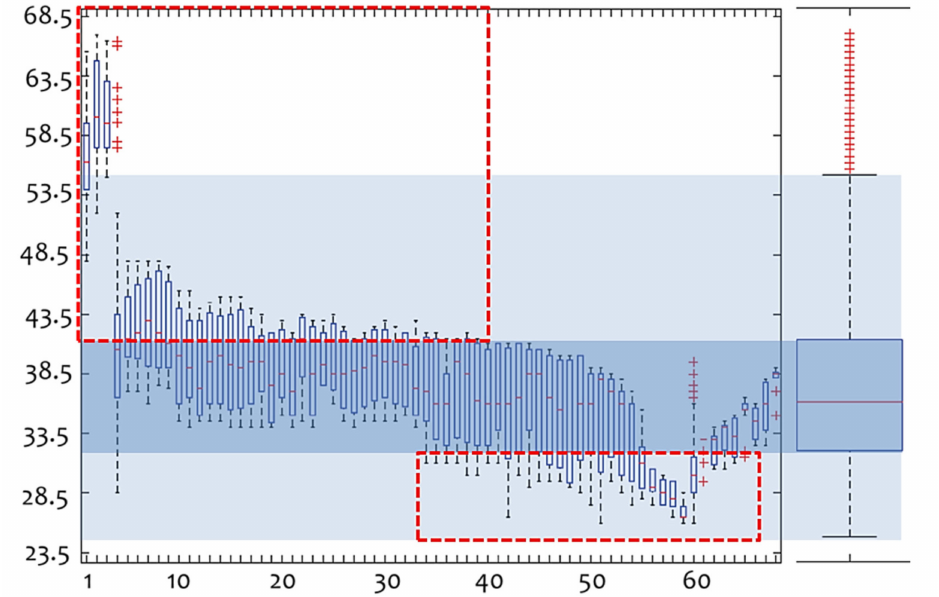
Figure 7. Areas exceeding the interquartile range of the box-plot distributions of the 68 communities resulting from the community detection analysis based on the modularity optimization algorithm of